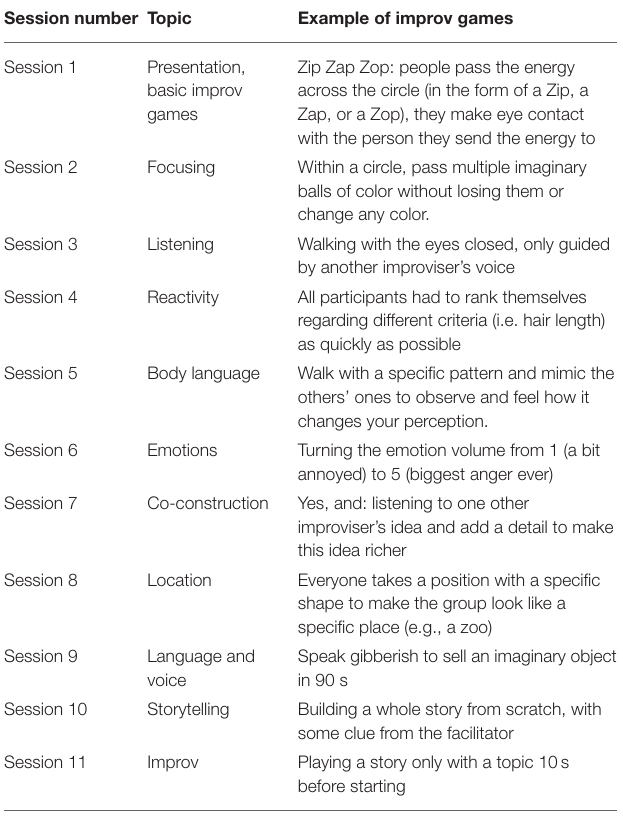
TABLE 1 | Improv sessions description. Session number Topic Example of improv games